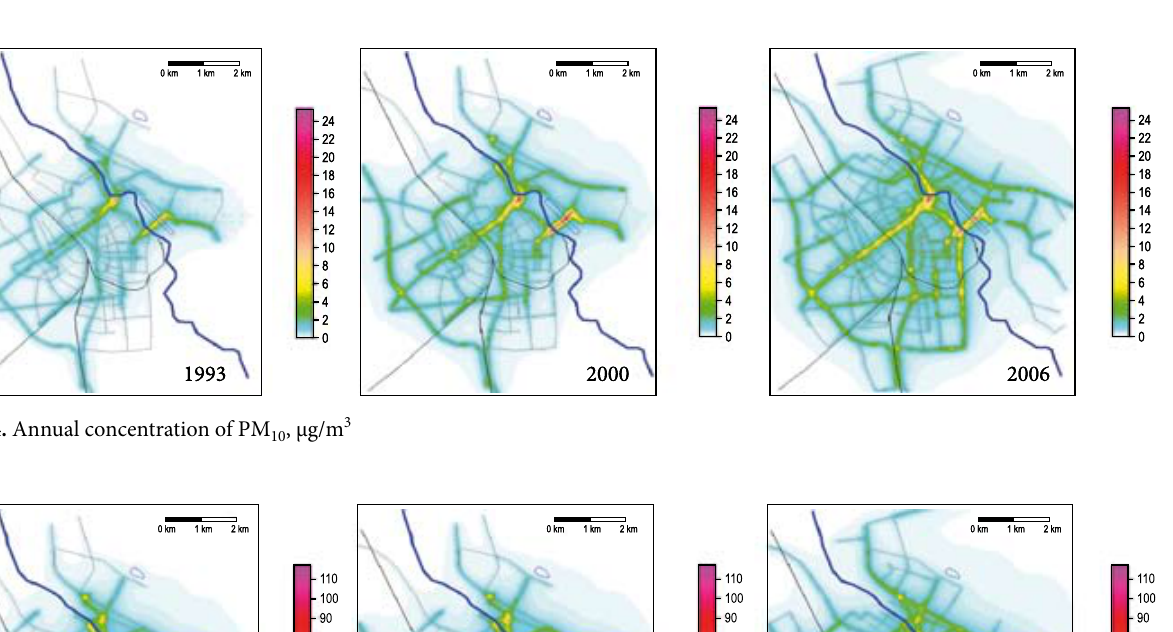
fig. 3. Annual concentration of PM exhaust , μg/m 3